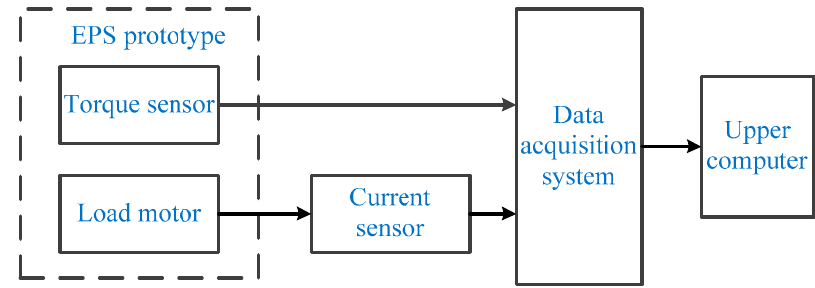
Figure 26. Overall block diagram of the EPS electric motor parameter identification experiment platform.